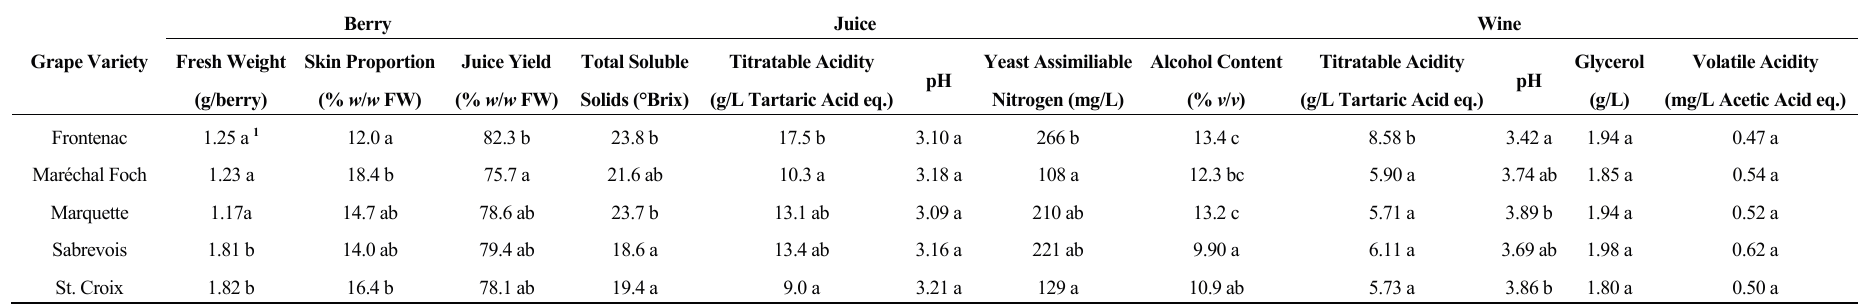
Table 1. Berry and juice quality attributes of the interspecific hybrid grape Frontenac, Maréchal Foch, Marquette, Sabrevois, and St. Croix harvested in the province of Québec (Canada), during the season 2012, and basic chemical composition of the produced wines. Grape